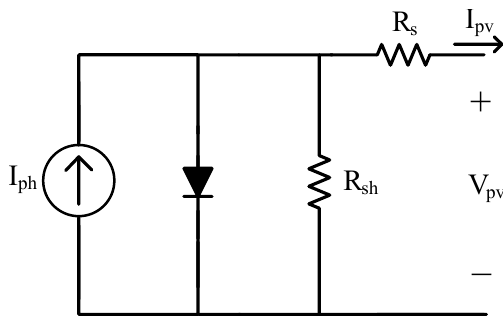
Figure 1. Equivalent circuit of single diode